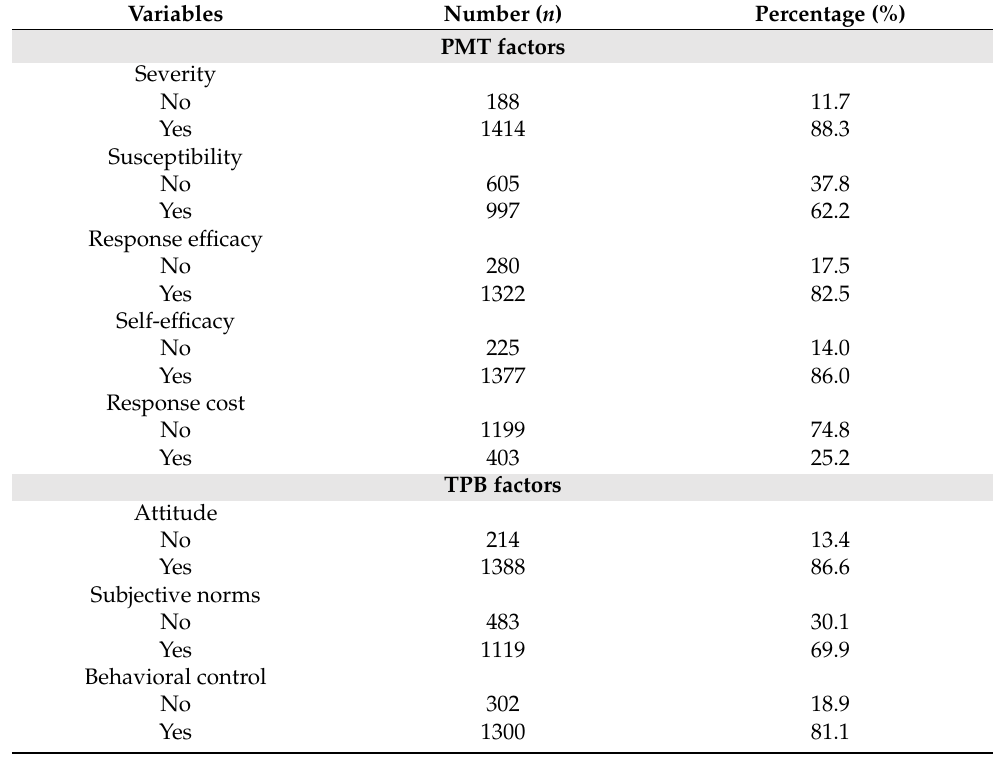
Table 2. Parents’ psychological perception of PMT and TPB ( n =